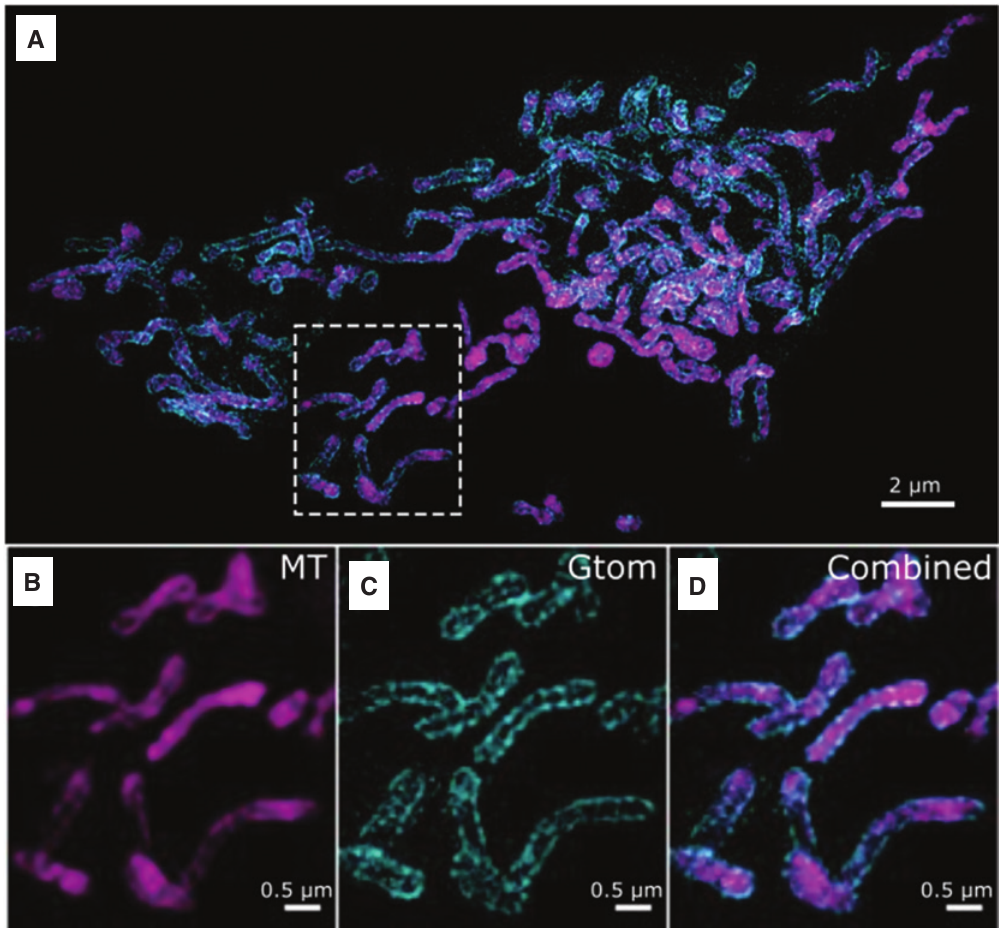
Figure 2: Live imaging of an MCC13 cell dually labeled with Gtom and MT. The region indicated in (A) is shown magnified below with separate (B, MT; and C, Gtom) and merged color channels (D). Images are maximum intensity projections of a 3- μ m 3D SIM z-stack. A single z-slice image with orthogonal views are found in Supplemental Figure